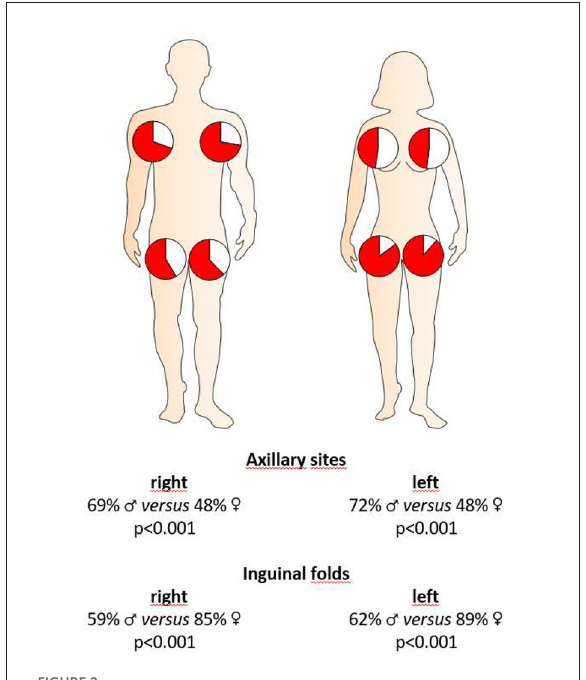
FIGURE2 Localization of HS skin lesions in both sexes at the time of clinical presentation. Red coloration in the pie charts accounts for the percentage of female or male HS patients with respective localization of skin alterations. Significance of differences was assessed by the Chi-square